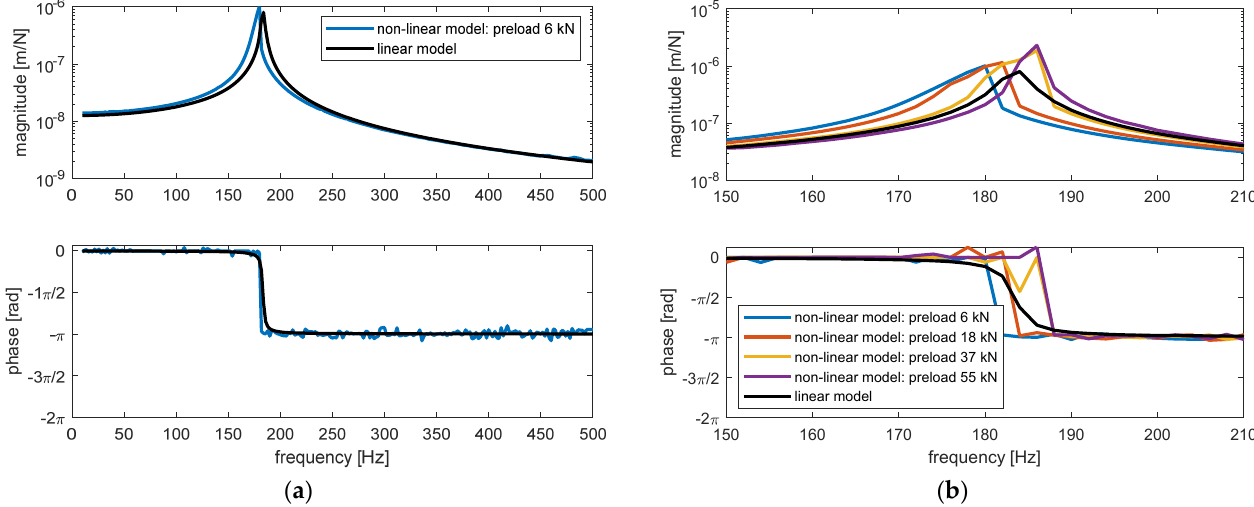
Figure 12. Amplitude ratio (upper plot of each part) and phase delay (lower plot of each part) of the steady-state responses of the rail and the external harmonic force, obtained with time domain simulation by linear and non-linear mechanical models of unit length of the ERS: ( a ) preload of 6 kN and dynamic force amplitude of 1 kN; ( b ) preload of 6 kN, 18 kN, 37 kN, 55 kN, and dynamic force amplitude of 1 kN.